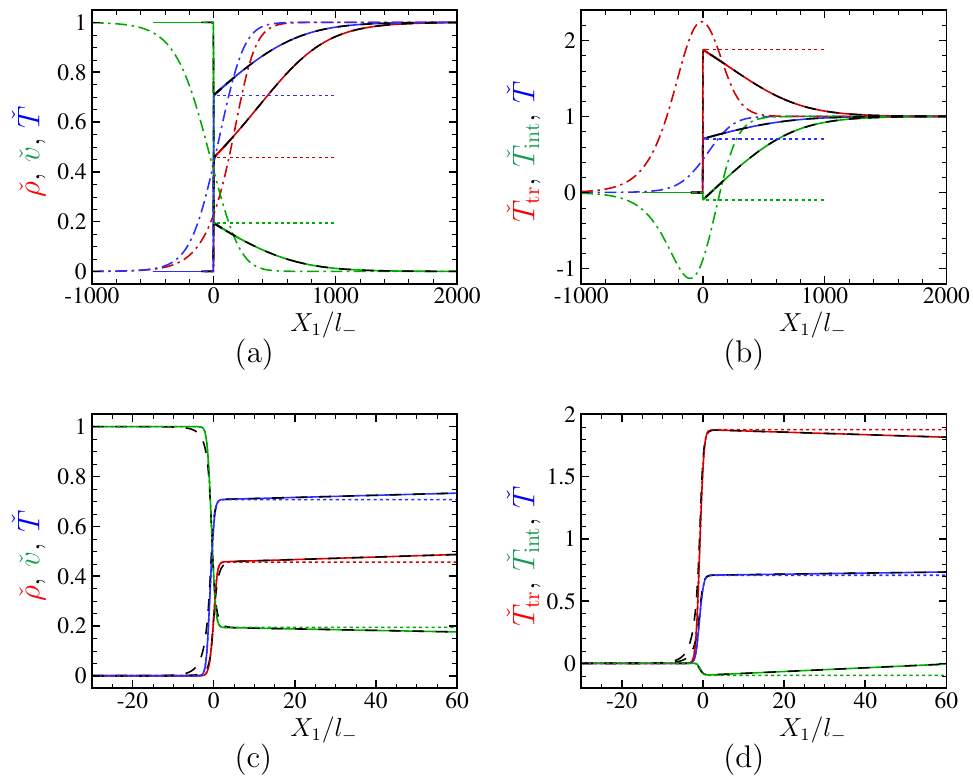
Figure 7. Profiles of ˇ ρ , ˇ v , ˇ T , ˇ T tr , and ˇ T int in the case of the pseudo-CO 2 gas at M − = 3 for µ b / µ = 1000. ( a , c ) ˇ ρ , ˇ v , and ˇ T ; ( b , d ) ˇ T tr , ˇ T int , and ˇ T . See the caption of Figure